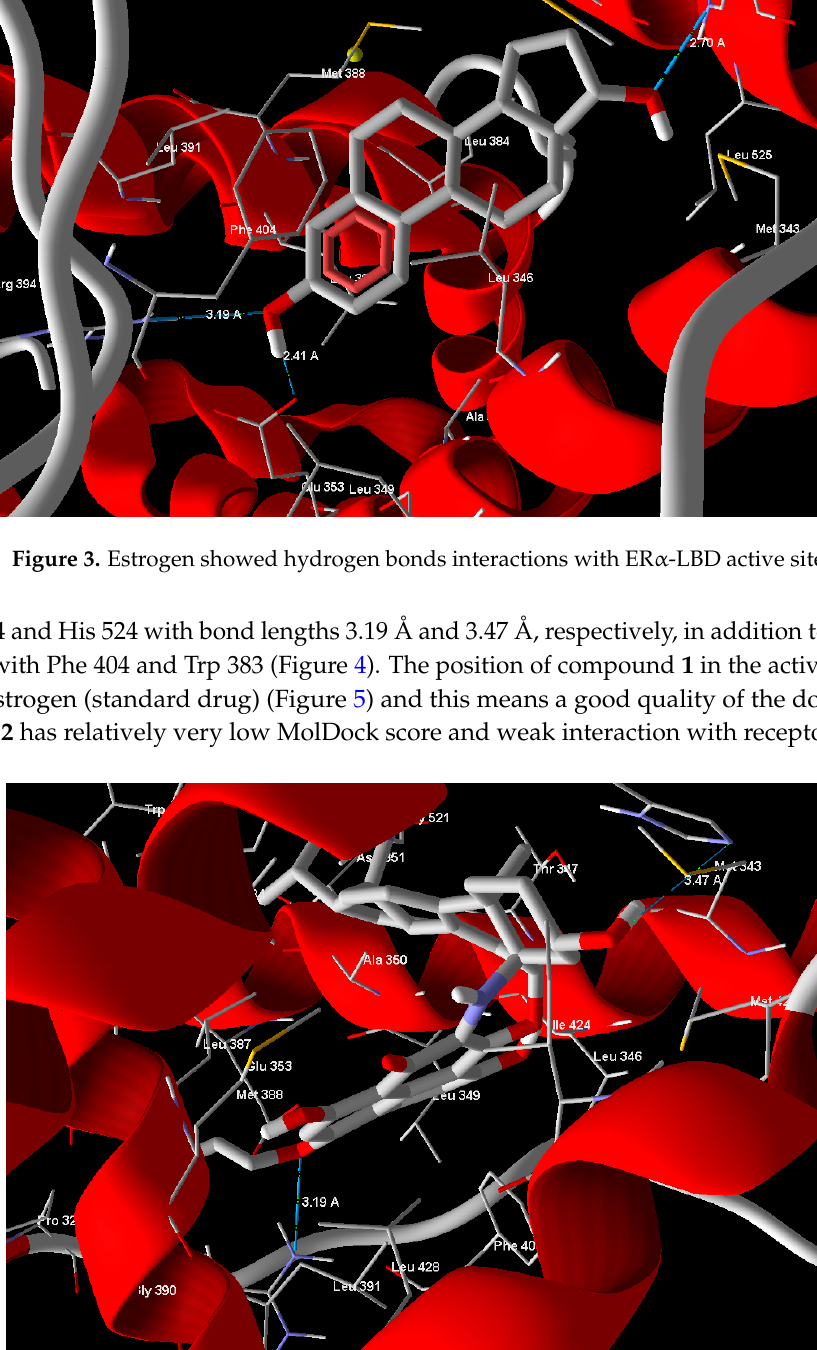
Figure 5. Compound 1 (red molecule) superimposed with standard drug (green molecule) in ER α -LBD active site (Color figure online). 3. Materials and Methods 3.1. General Experimental Procedures UV and IR spectra were obtained employing Perkin-Elmer Lambda 40 and Perkin-Elmer Spectrum BX instruments (PerkinElmer, Inc., Waltham, USA), respectively. VLC grade